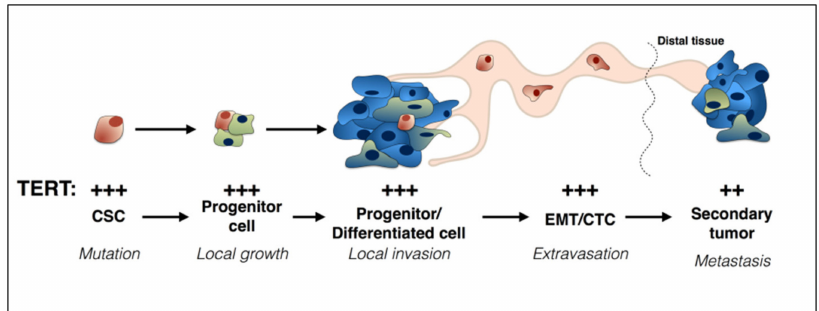
Figure 1. Telomerase reverse transcriptase (TERT) is expressed at every stage of cancer progression. The sign + refers to gene